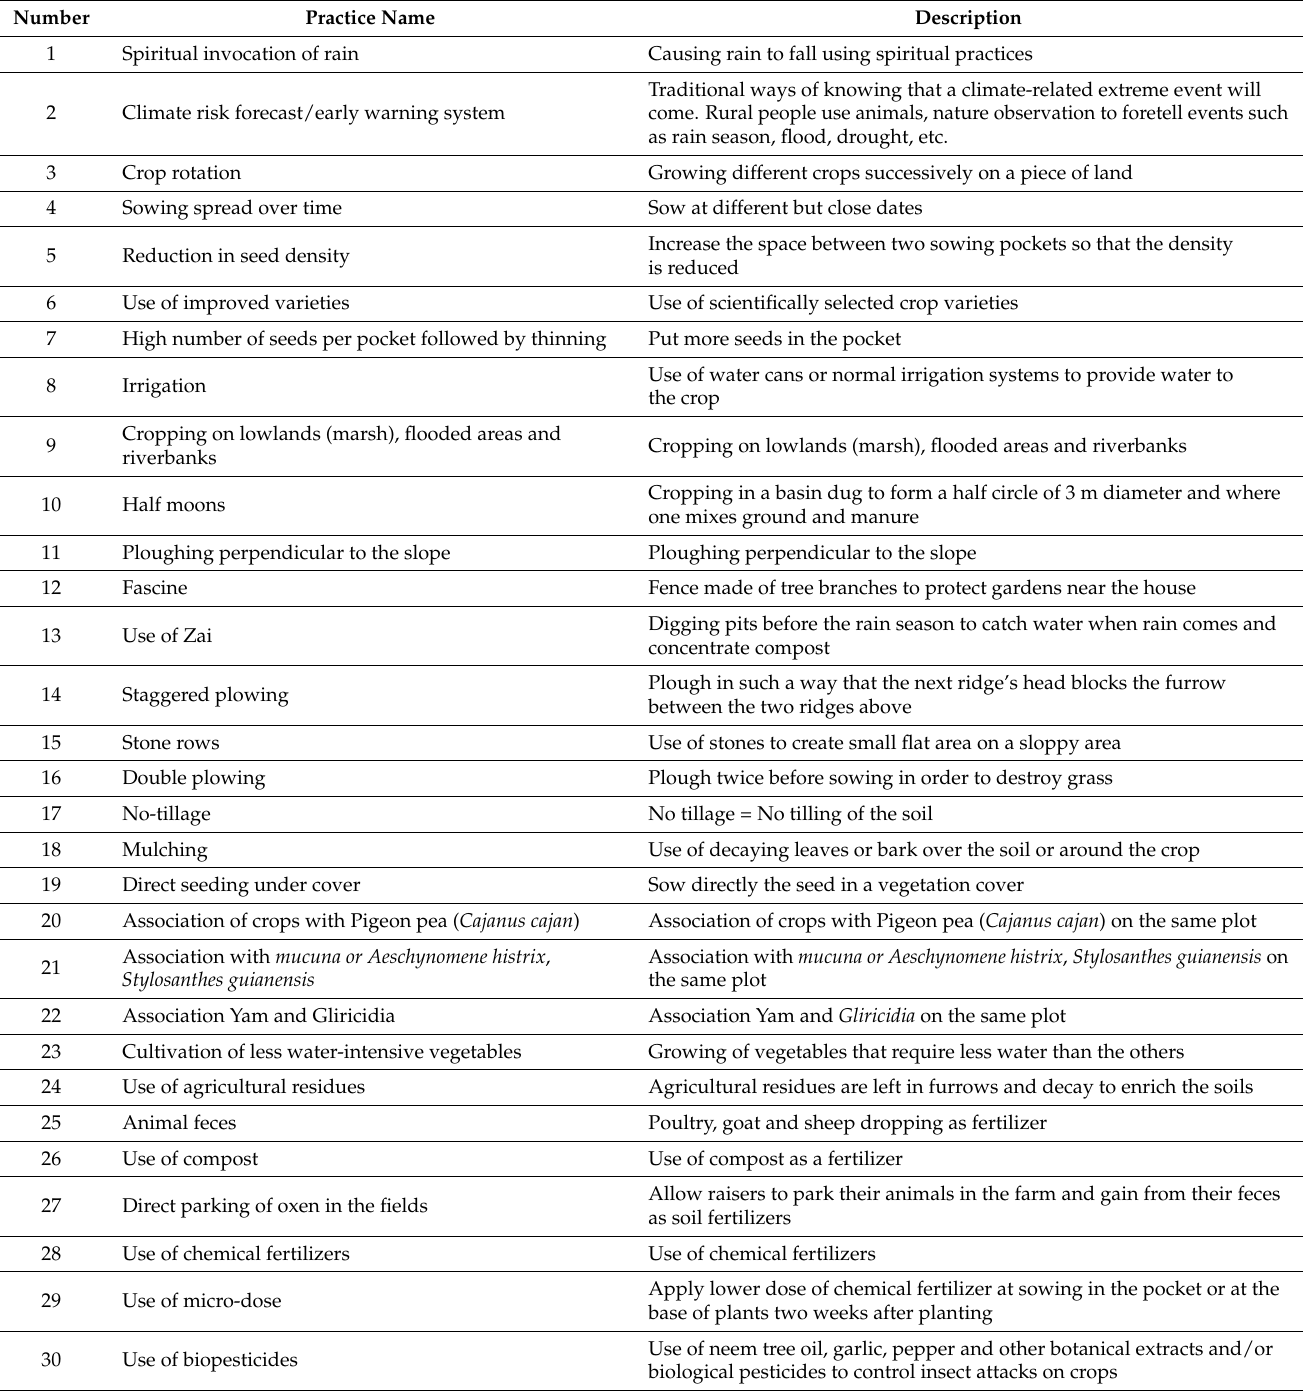
Table A1. Description of CSA as provided by